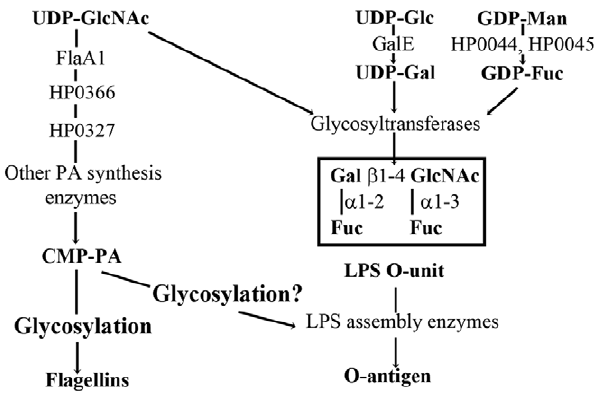
Figure 1. Schematic representation of key steps of the PA and LPS biosynthesis pathways. The main enzymes responsible for the synthesis of sugar nucleotides are indicated, including the dehydratase FlaA1 and the aminotransferase HP0366 relevant to this work. The links between both pathways are highlighted, namely a shared precursor UDP-GlcNAc, and the potential glycosylation of LPS assembly enzymes by PA.